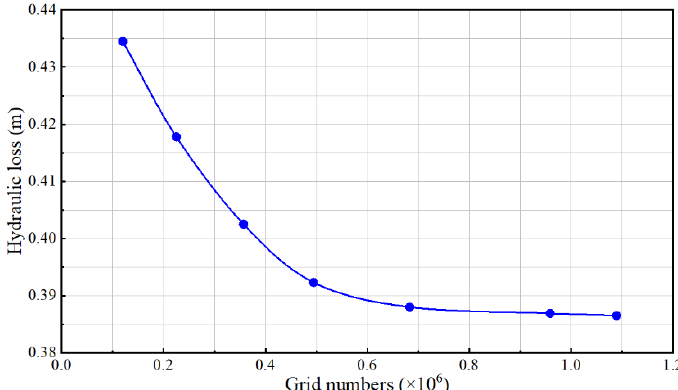
Figure 5. Variation law of hydraulic loss under different grid numbers. Table 2. Grid distribution of computational domains.